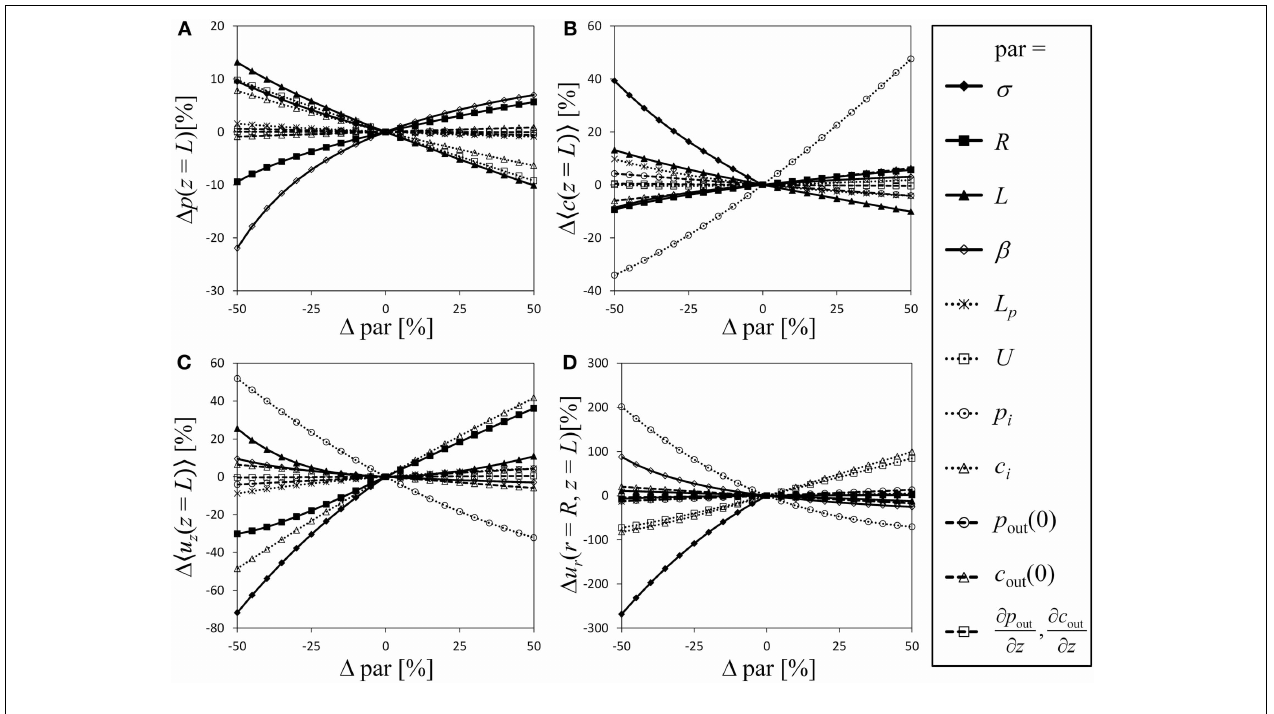
FIGURE 4 | Sensitivity analysis. Varying all relevant model parameters up to ± 50% from the values of Table 1 , the resulting relative change of the state variables (at the end of the tube, i.e., z = L ) is shown as indicator of model sensitivity. State variables are pressure (A) , average solute